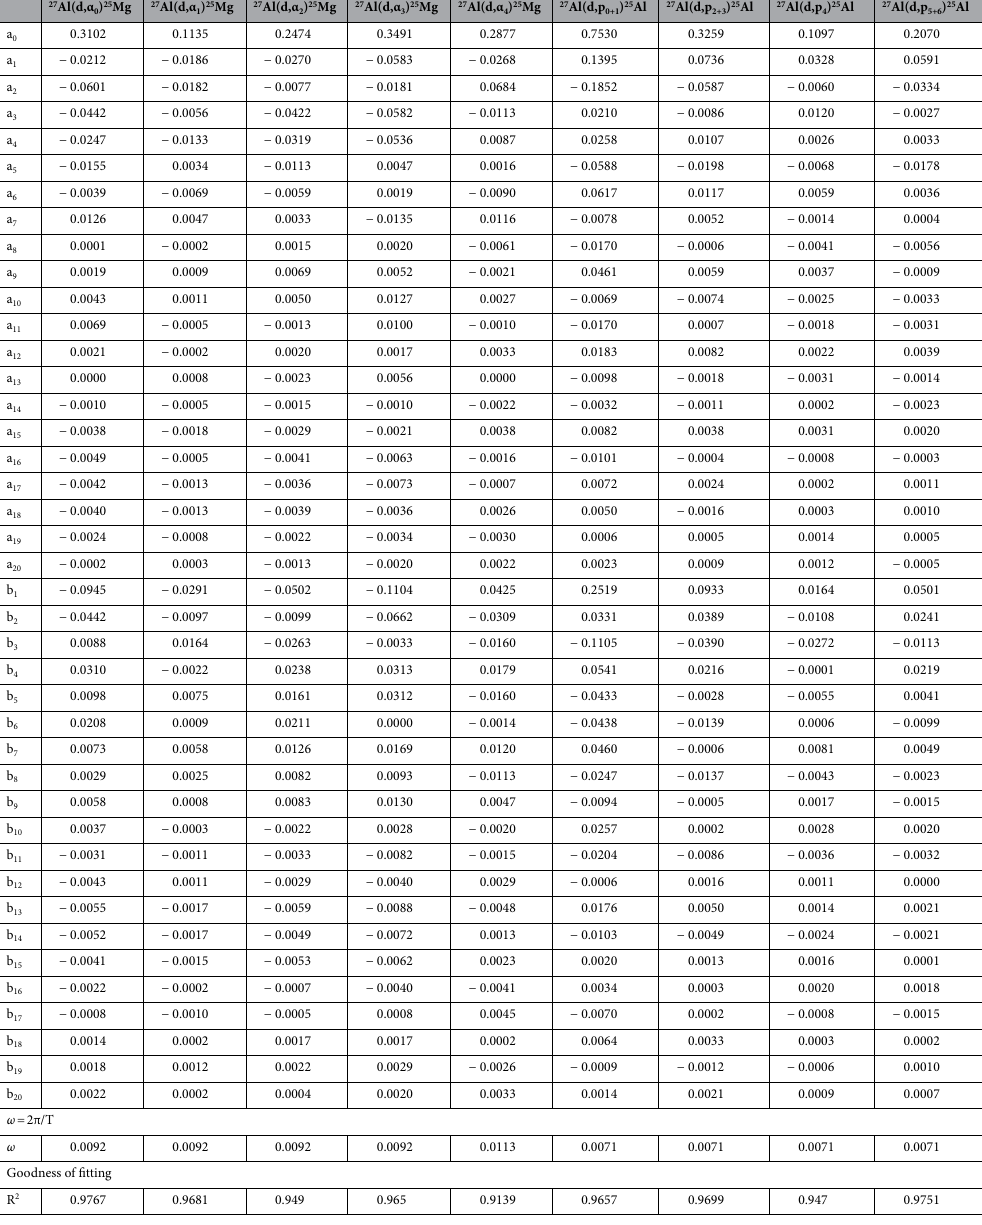
Table 1. The coefficients and Goodness of fitting for final